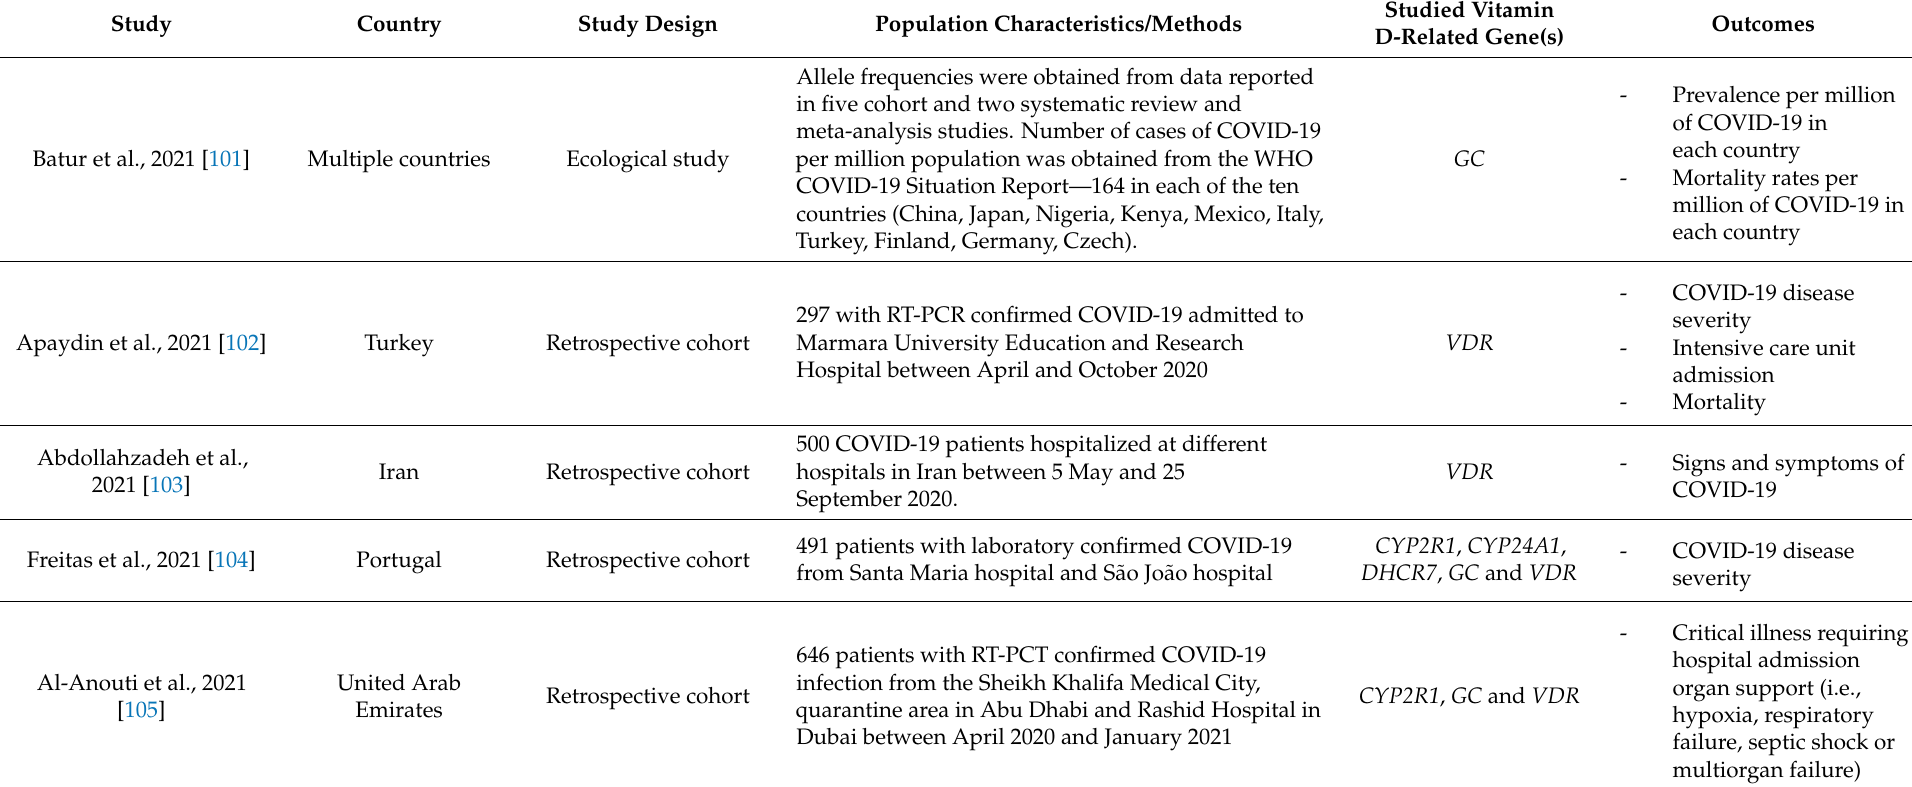
Table 1. Characteristics of studies investigating the association between vitamin D-related genetic variations and COVID-19 susceptibility and